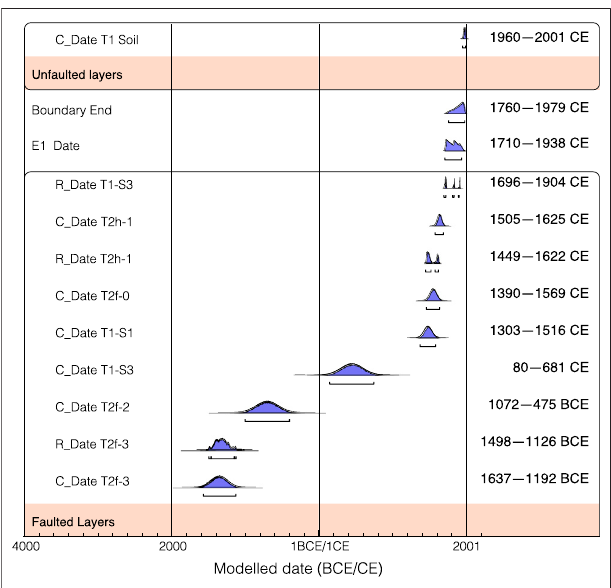
FIGURE 8 | 14 C ages of detrital charcoal (R_Date) from Dungsam Chu palaeoseismic exposure calibrated using the phase model of OxCal. The OSL data were input by converting the laboratory OSL age to calendar date (C_Date), including the laboratory uncertainties (Lienkaemper and Ramsey, 2009). In this scenario, the two oldest OSL ages were excluded to present the younger ages at a higher resolution. Dark gray areas show posterior probability distributions resulting from the Bayesian phase model of OxCal. Light gray areas show the standard (unmodelled) probability